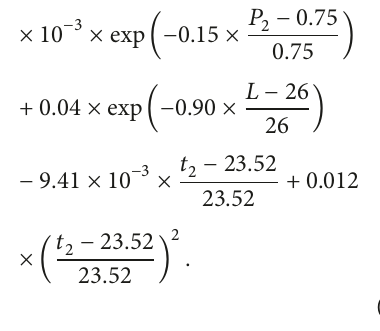
and increasing catalyst content in the range of 0.01–0.035% . 𝑓 T also appears to increase with the reduces 𝑓 T - TPA - TPA temperature and decrease with pressure (Figures 5and 6).